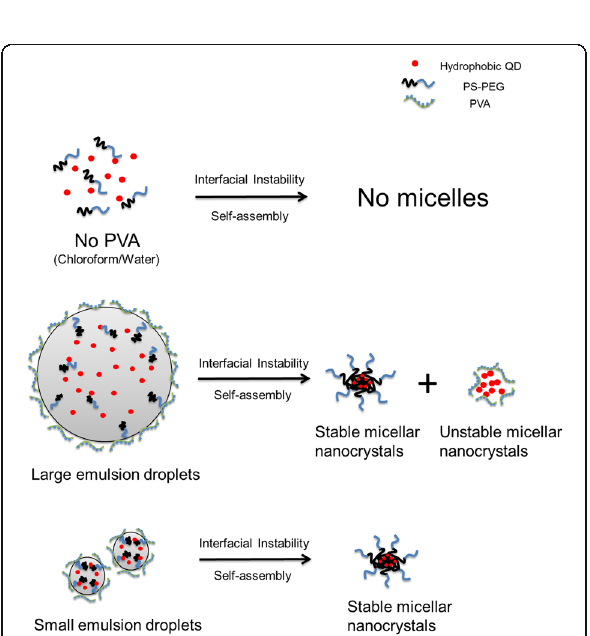
Fig. 5 Roles of emulsion droplet size and surfactant in the interfacial instability-based fabrication of micellar